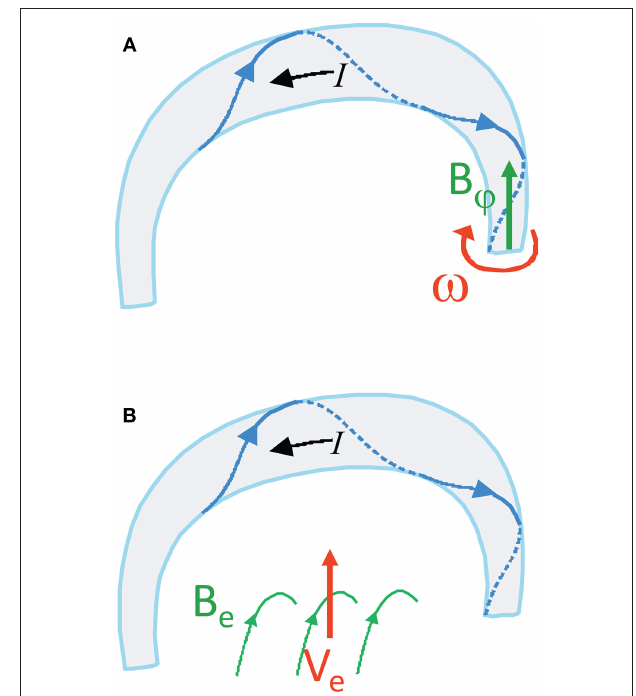
FIGURE 4 | Schematic presentation of: (A) poloidal flux injection (depicted by green arrow) into the rope, caused by twisting motion at the footpoint (red arrow); (B) emerging flux effect. For details see the main text.